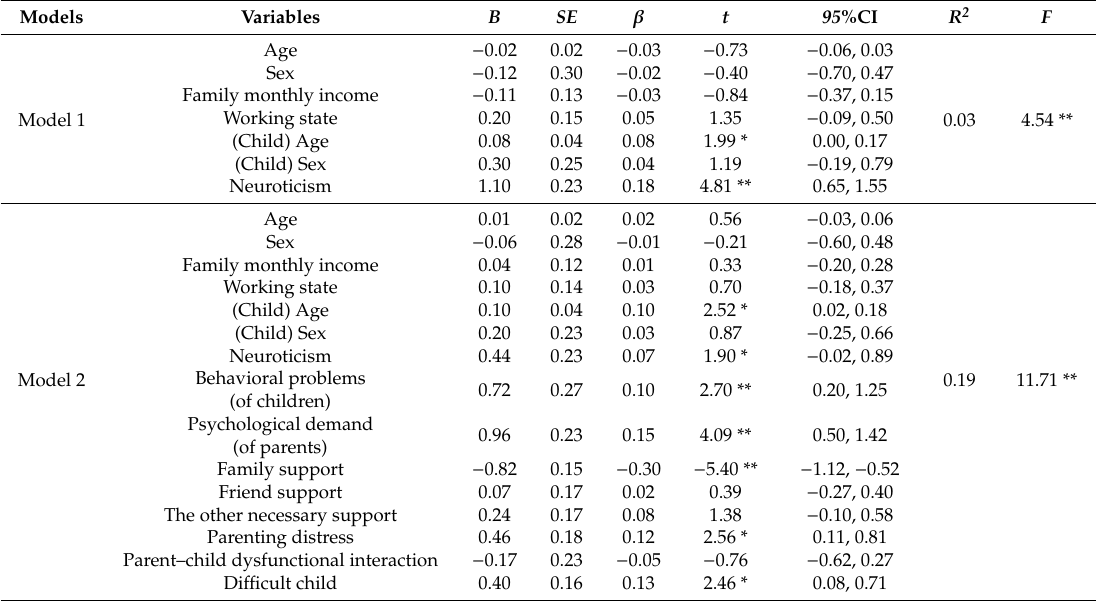
Table 3. Hierarchical linear regression analysis among parents of children with an intellectual disability. Models